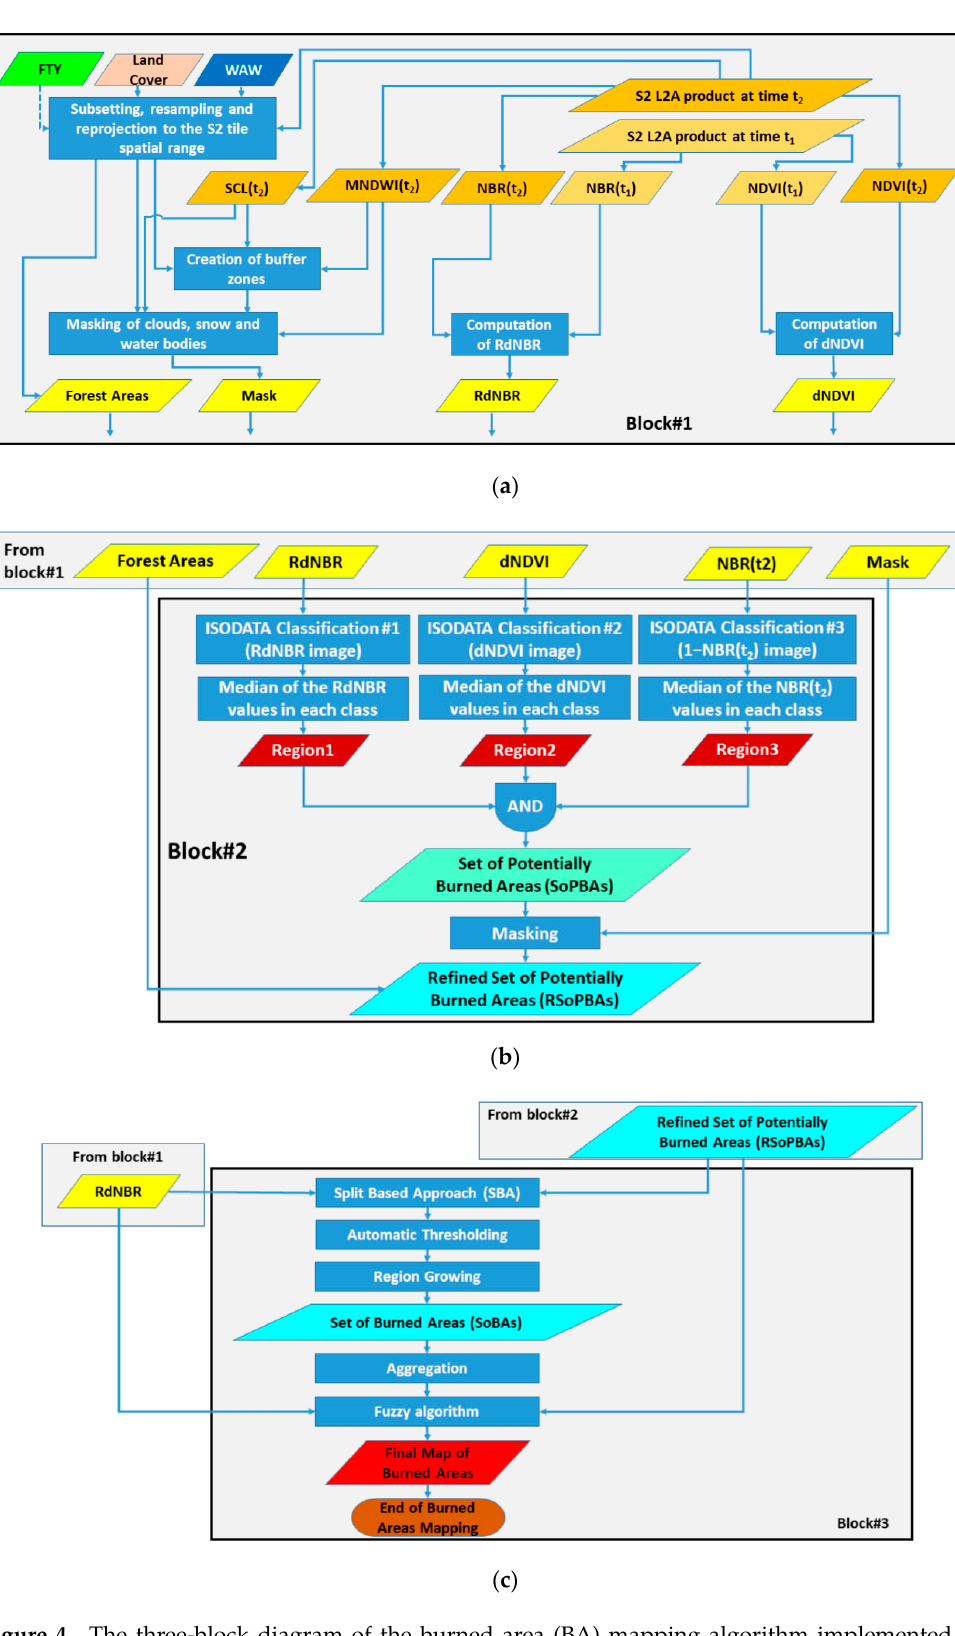
Figure 4. The three-block diagram of the burned area (BA) mapping algorithm implemented in AUTOBAM; ( a ) Block#1, ( b ) Block#2, and ( c ) Block#3. The diagram refers to a single S2 tile.